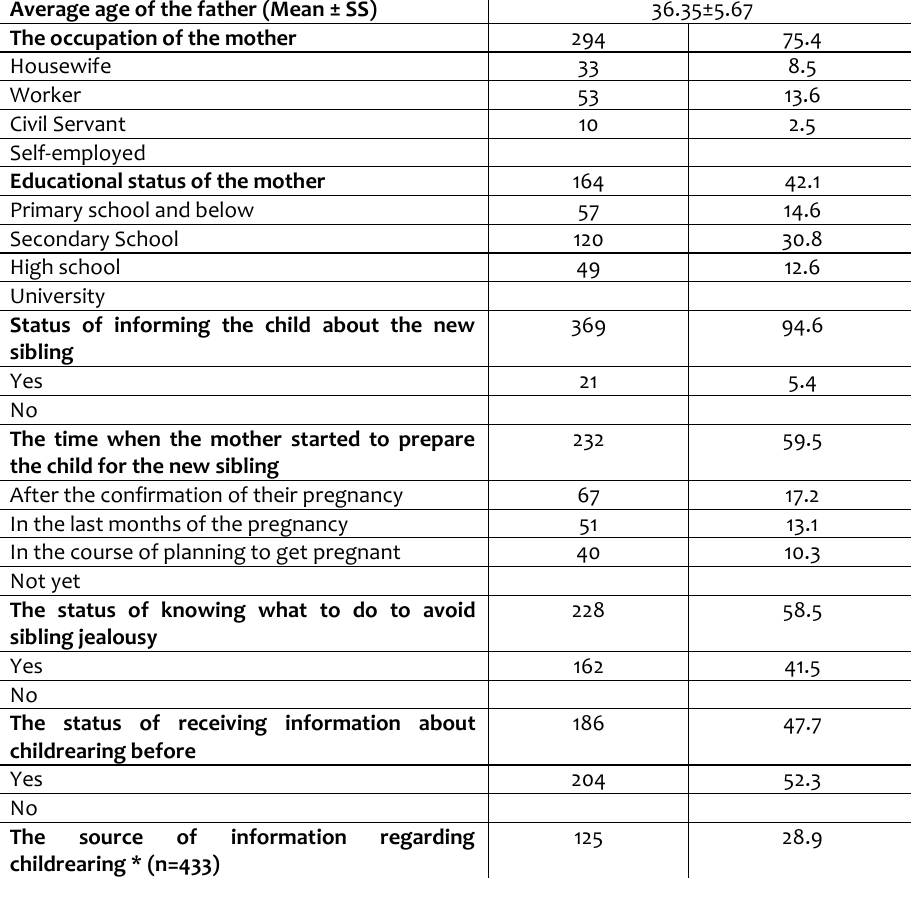
Table 1 . Socio-demographic characteristics of the expectant mothers and their status